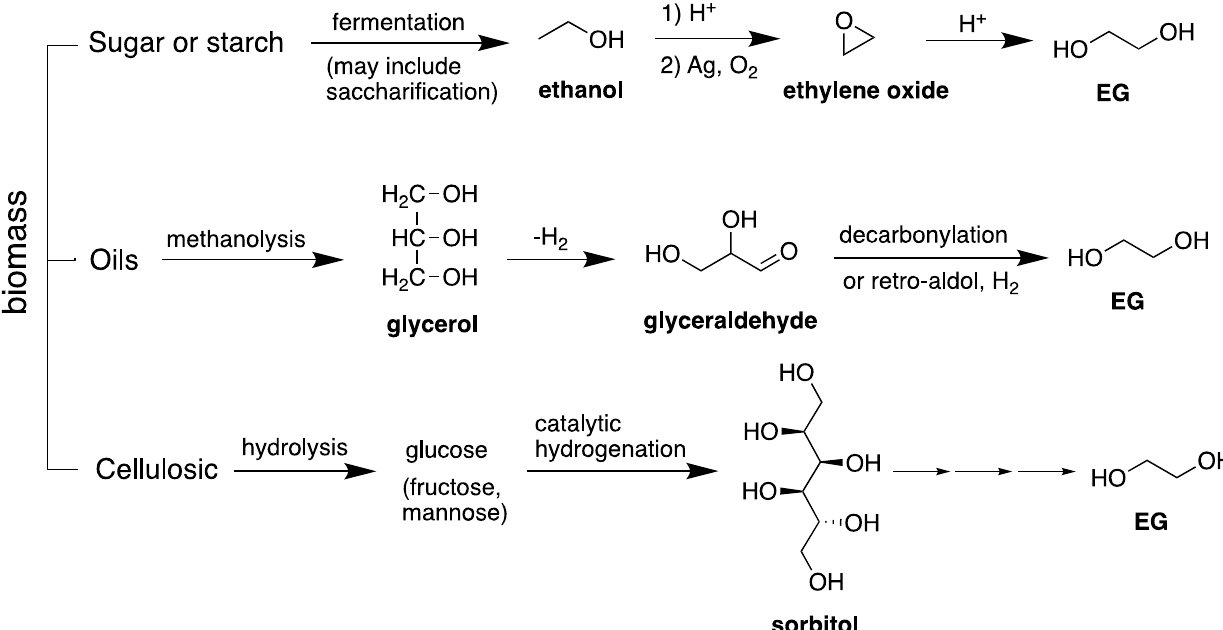
Figure 6. Simplified schematic showing several important chemical intermediates in the conversion of three different biomass raw materials to EG (compiled from refs. [119–121,123,131–133]). The other component of PET, TPA, has been a more elusive target for biomass-based production routes. Over the years, a number of companies have tried (and failed) to pro- duce bio-based p-xylene, an important intermediate that is converted to TPA by catalytic oxidation. Currently, the company Origin Materials has garnered much attention and sup- port from eventual corporate customers in their efforts to convert lignocellulosic biomass to 5-(chloromethyl)furfural (CMF), a precursor to p-xylene [134]. Figure 7a shows the chemical pathway from CMF to p-xylene. Bio-based CMF is a versatile precursor that can also be used for synthesizing products such as cyclohexanone, caprolactam, and hexa- methylenediamine (HMDA). In addition to Diels-Alder (DA) reaction between 2,5-dime- thylfuran (DMF) and ethylene [135], there are other chemical routes to obtain p-xylene or TPA from biomass. The raw materials can be bio-ethylene, isobutanol, isoprene and acrylic, limonene, and furfural [119]. For example, in a sequence of steps starting with a DA reaction, followed by dehydro-aromatization and oxidation, the starting materials bio-based isoprene (sugar fermentation product) and acrolein (glycerol dehydration prod- uct) [136] or acrylic acid can produce the target product, TPA monomer [137] (Figure 7b). ( a ) ( b ) Figure 7. Chemical pathways to produce p-xylene: ( a ) from CMF to p-xylene and ( b ) from isoprene to p-xylene or TPA (complied from refs. [119,134,137]).